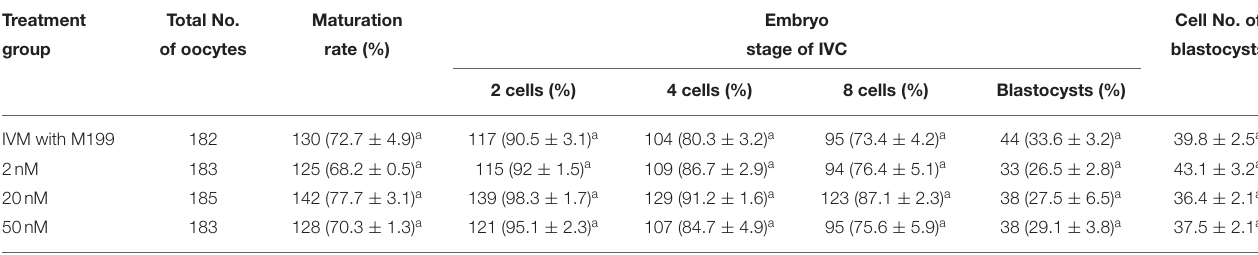
TABLE 8 | Effects of IVM media supplemented with let-7f-5p on the development of parthenogenetic activation porcine embryos. Treatment Total No. Maturation Embryo Cell No. of